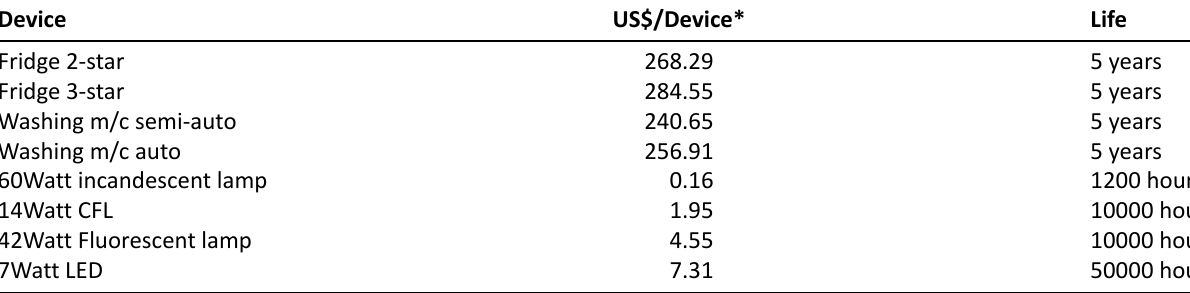
Table A6. Household electric appliances, based on Department of renewable Energy (2015a, 2015b). Device